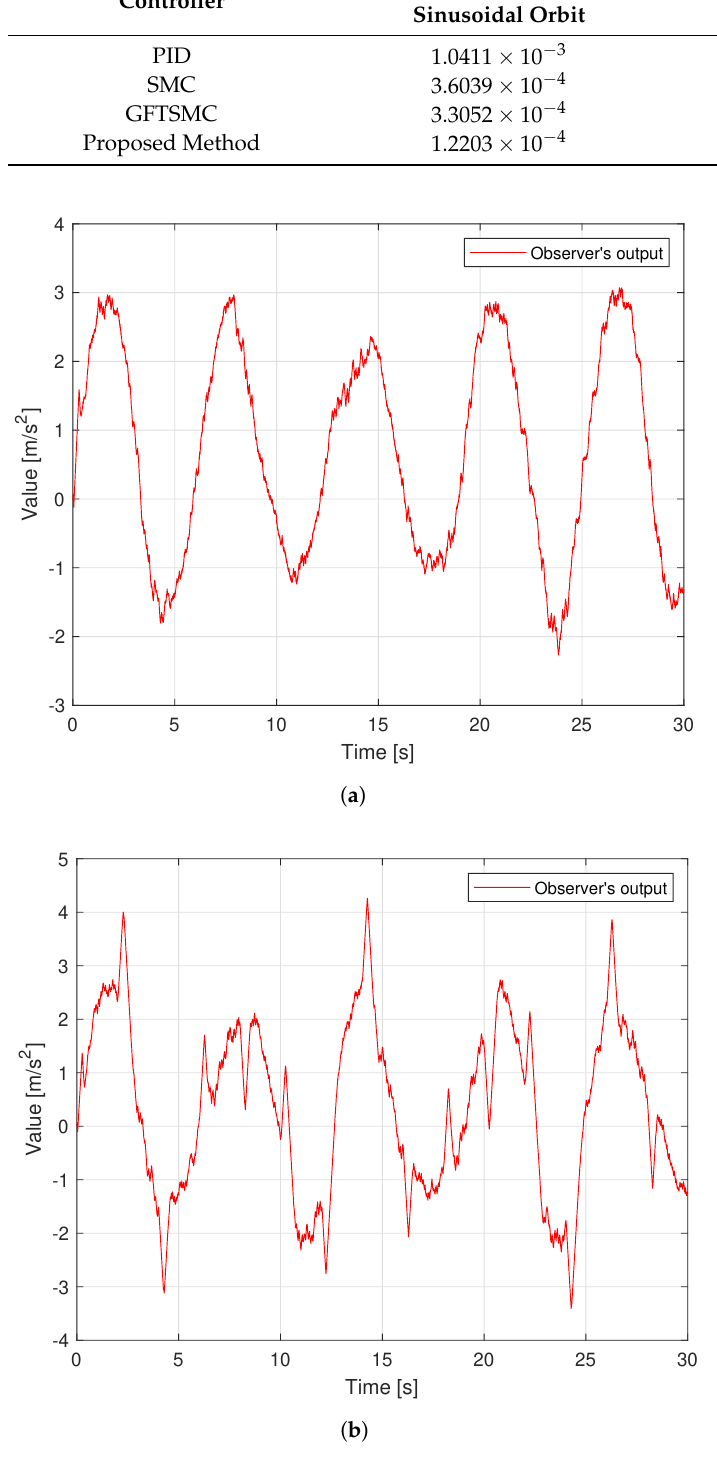
Figure 14. Time evolution of the MTOSMO’s output; ( a ) in case of sinusoidal orbit; ( b ) in case of a rest-to-rest